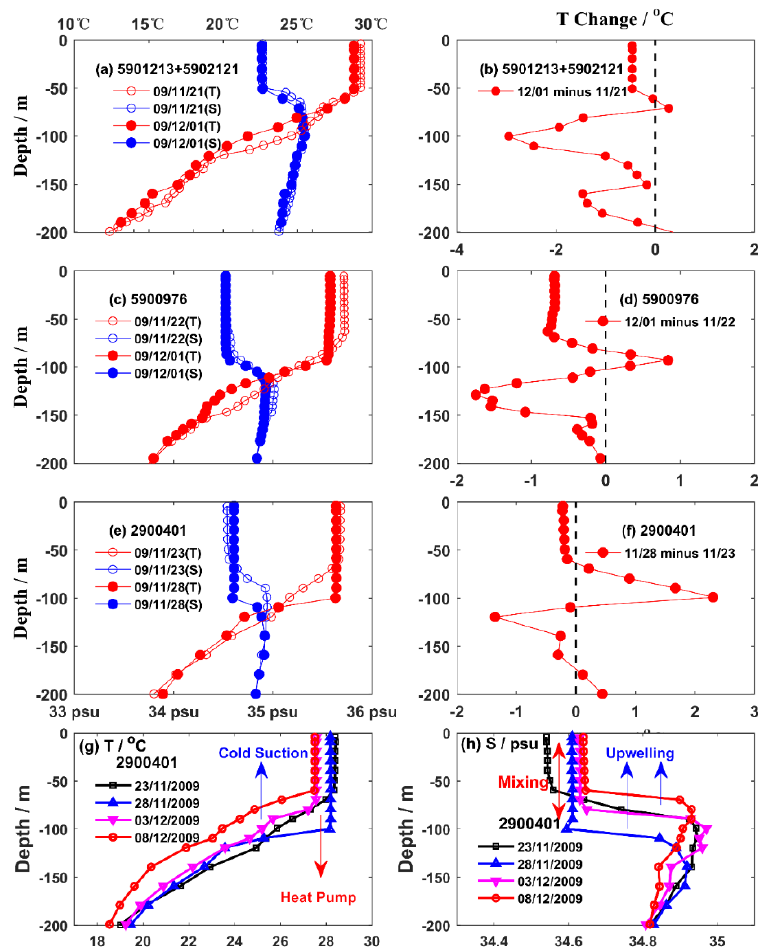
Figure 7. Temperature and salinity profiles, and temperature differences between the post-storm and pre-storm, measured by Argo floats 5901213 and 5902121 ( a , b ), 5900976 ( c , d ), and 2900401 ( e , f ). ( g , h ) Temporal evolution of temperature and salinity profiles measured by Argo float 2900401 before and after Nida.